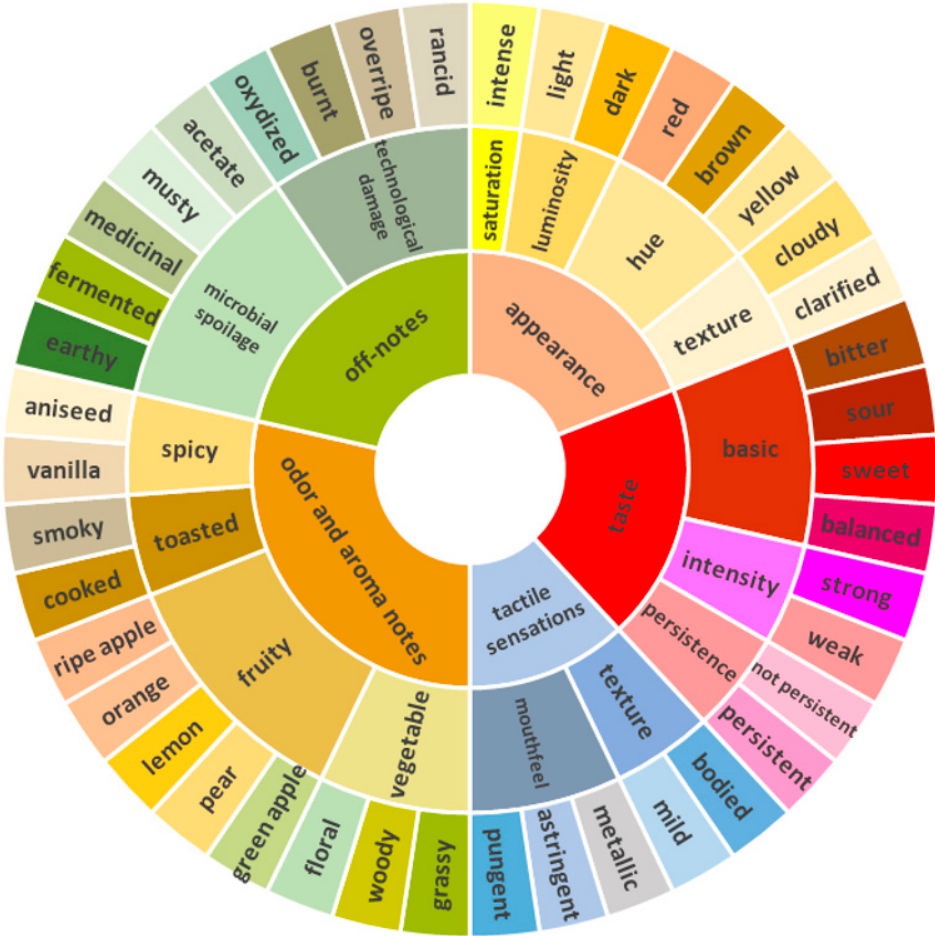
Figure 6. Sensory wheel developed with sensory attributes selected from the text-mining